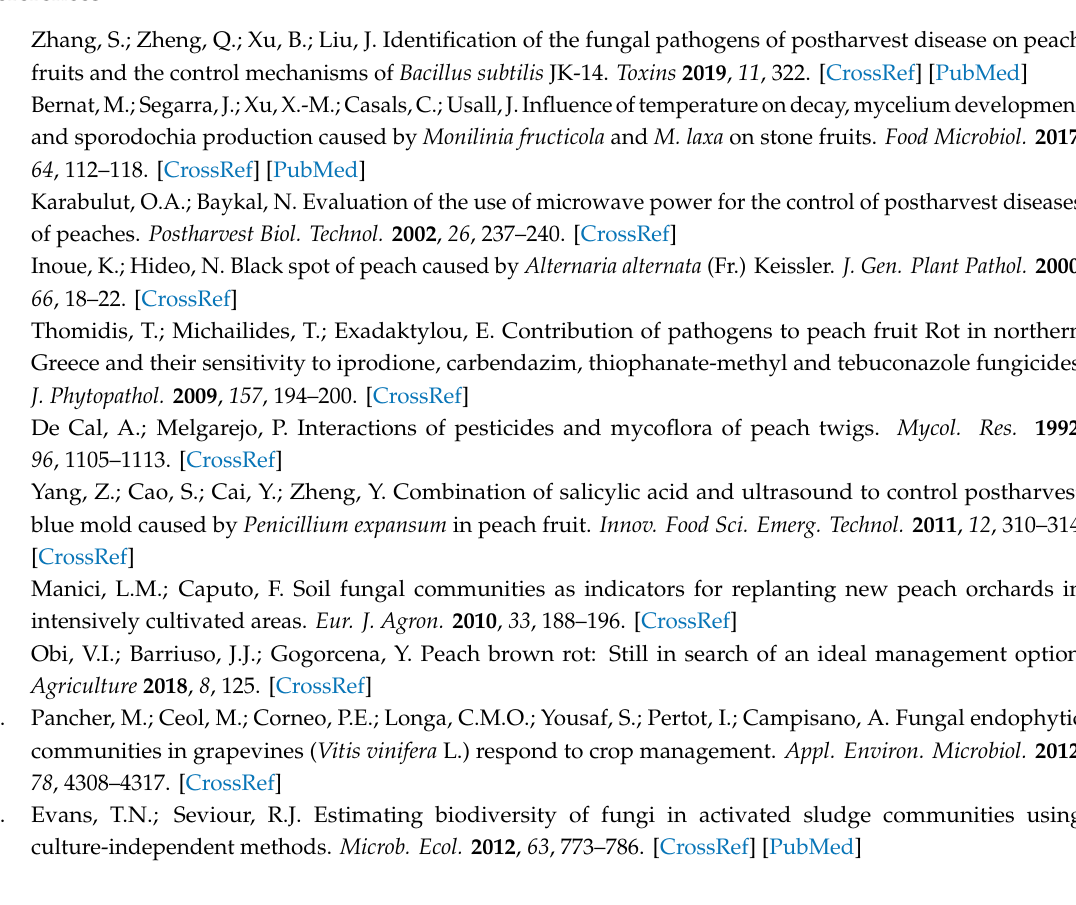
Table S1: The number of reads associated with fungi in six di ff erent libraries, Table S2: The number of reads associated with bacteria in six di ff erent libraries, Table S3: The number of reads associated with viruses in six di ff erent libraries, Figure S1: Identification of microorganisms from the D4 and R4 libraries using KRAKEN 2 program, Figure S2: Identification of microorganisms from the D7 and R7 libraries using KRAKEN 2 program. Author Contributions: Y.J. and C.-G.B. are the main authors of this paper. Y.J., C.-G.B., H.C., and W.K.C. performed the nucleic acid extraction, library preparation and sequencing. Y.J. and H.C. performed bioinformatics analyses. C.-G.B. and W.K.C. harvested samples and observed disease symptoms. C.-G.B. helped interpret the data and discussed the results. This project was conceived and designed by Y.J., C.-G.B., and W.K.C. W.K.C. wrote